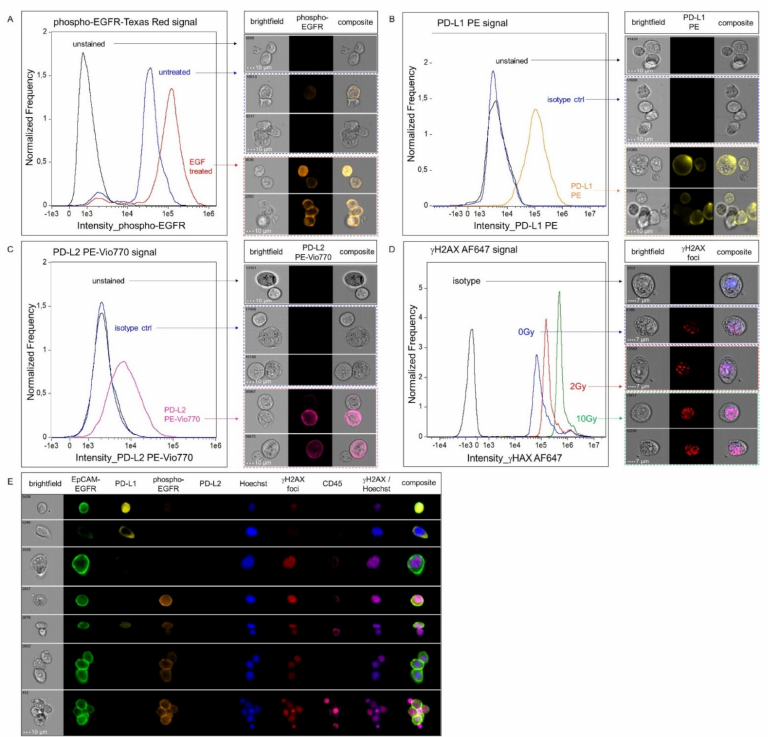
Figure 3. Immunofluorescence analysis of phospho – EGFR, PD – L1/PD – L2 and γ H2AX and multi- parametric phenotyping . ( A ) Representative results of phospho–EGFR staining in UM–SCC–22B cells are shown. The histogram displays the fluorescence intensities in unstained (black), untreated (blue) and EGF–treated (red) cells. ( B , C ) Positive and negative cells for surface staining of PD–L1 (B) and PD–L2 (C) on MDA–MB–231 and SCC–25 cells, respectively, are shown. Fluorescence intensities for unstained (black), isotype control (blue) or samples stained with either anti–PD–L1 (orange) or anti–PD–L2 antibody (pink) are depicted. Clusters of cells were selected to demonstrate the heterogeneity of each cell line and the feasibility of the ISX to detect different expression intensities with high sensitivity. ( D ) γ H2AX staining was performed in FaDu cells, untreated (blue) or irradiated with 2 Gy (red) or 10 Gy (green). Isotype control is shown in black. Representative images for the different conditions (acquired with the 60 × objective at low speed) are presented at the right column of the figure. ( E ) Multiparametric phenotyping of spiked EGF–treated and irradiated FaDu cells in peripheral blood (acquired with 40 ×